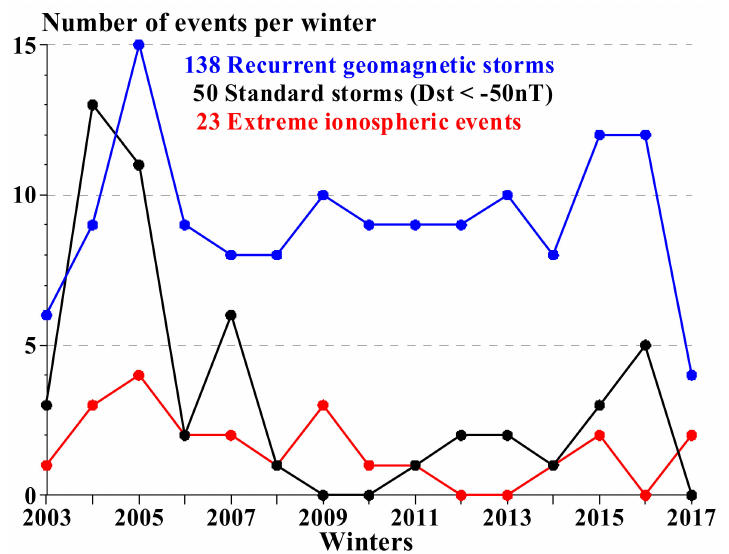
Figure 5. Winter-by-winter variations in number of following events: RGSs (blue), SGSs (black), and extreme ionospheric events at Irkutsk